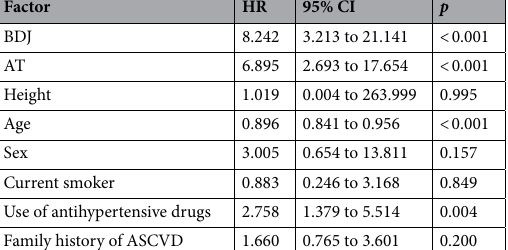
Table 6. Cox proportional hazards model analysis of changes in the 10-year ASCVD risk. BDJ, Baduanjin; AT, aerobic training; ASCVD, atherosclerotic cardiovascular